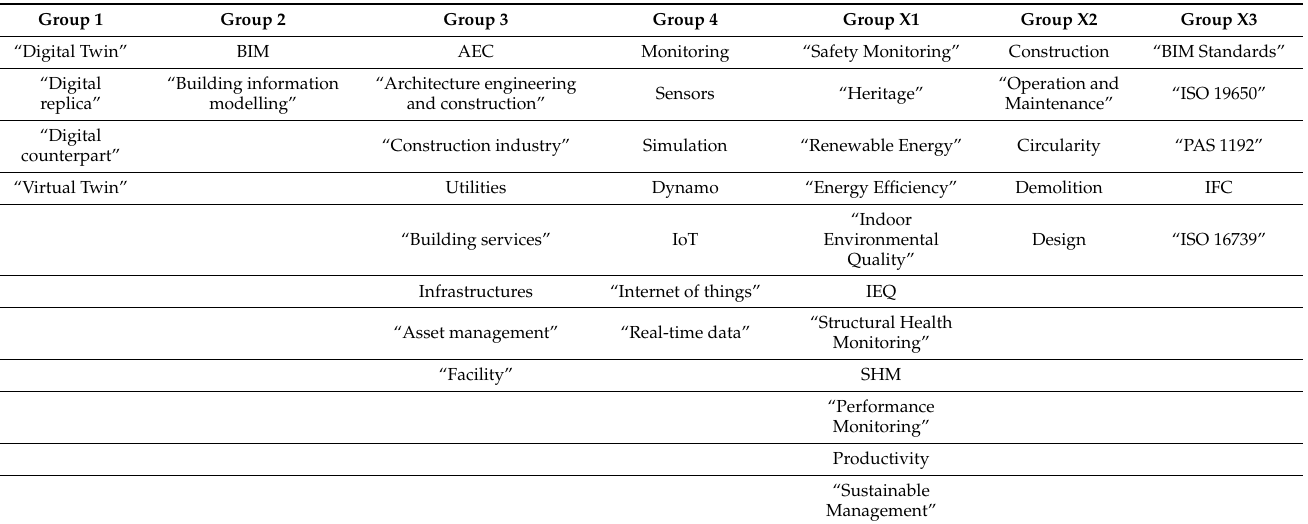
Table 1. Grouped list of search keywords.